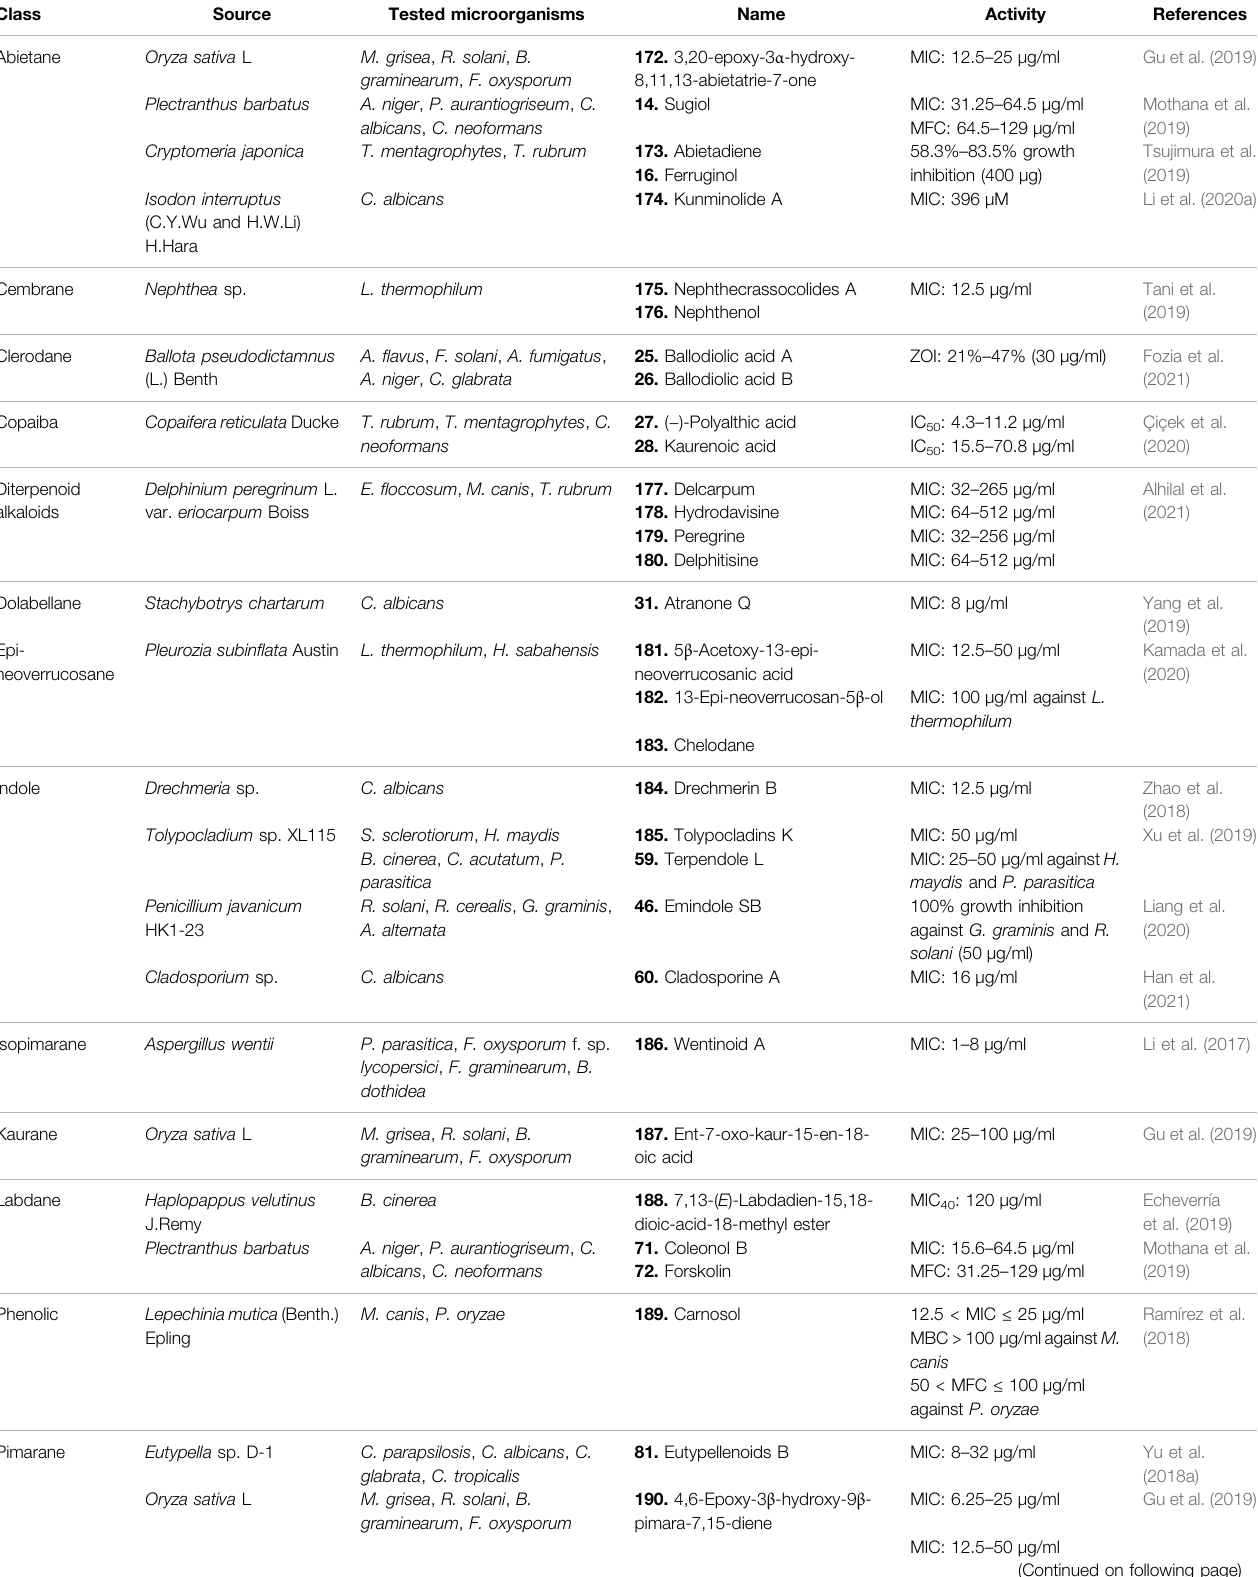
TABLE 3 | Different classes of diterpenoids isolated from natural sources with signi fi cant antifungal